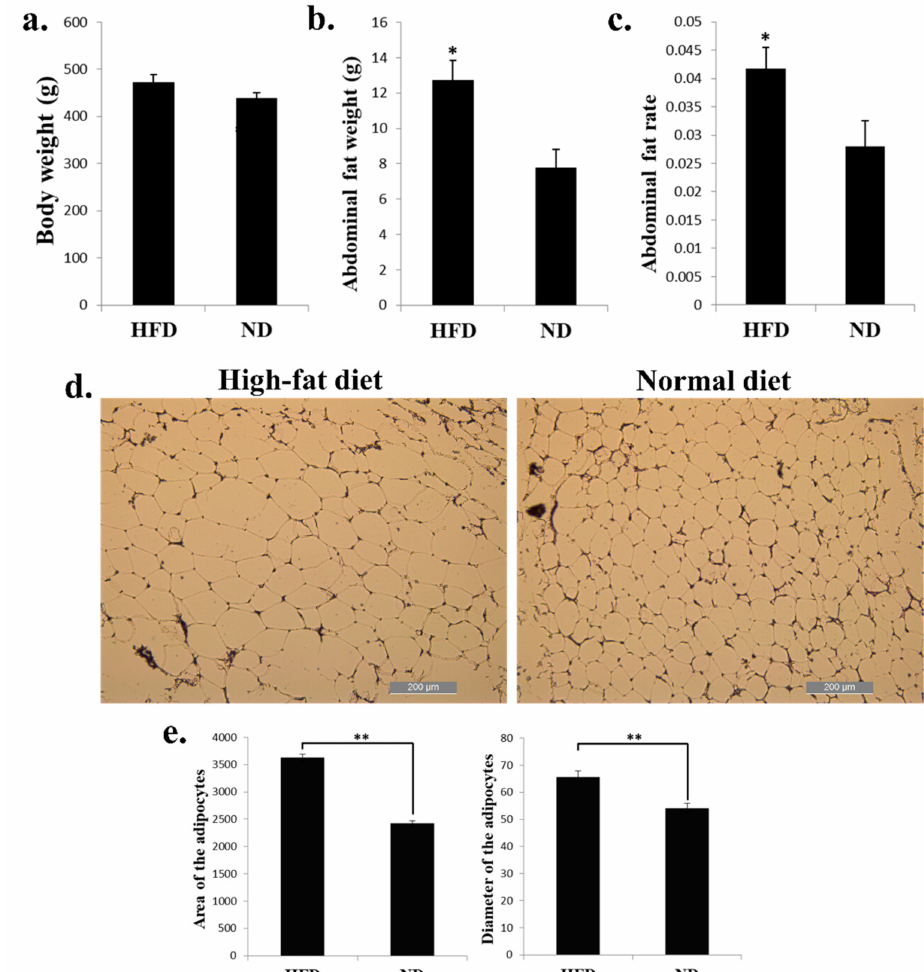
Figure 1. High-fat diet promotes chicken abdominal fat deposition and induces adipocyte hypertrophy. ( a ) Body weight of the broilers fed with high-fat diet (HFD) and normal diet (ND). ( b ) Abdominal fat weight of the broilers fed with HFD and ND. ( c ) Abdominal fat rate of the broilers fed with HFD and ND. ( d ) Micrograph of abdominal fat cross-section from HFD (left) and ND (right) chickens. Bar, 200 µ m. ( e ) Area (left) and diameter (right) of the adipocyte from HFD and ND chicken abdominal fat. * p < 0.05; ** p <